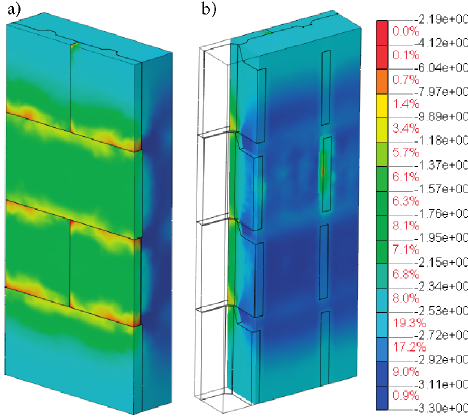
Fig. 10. Distribution of P-30 masonry fragments compressive stresses